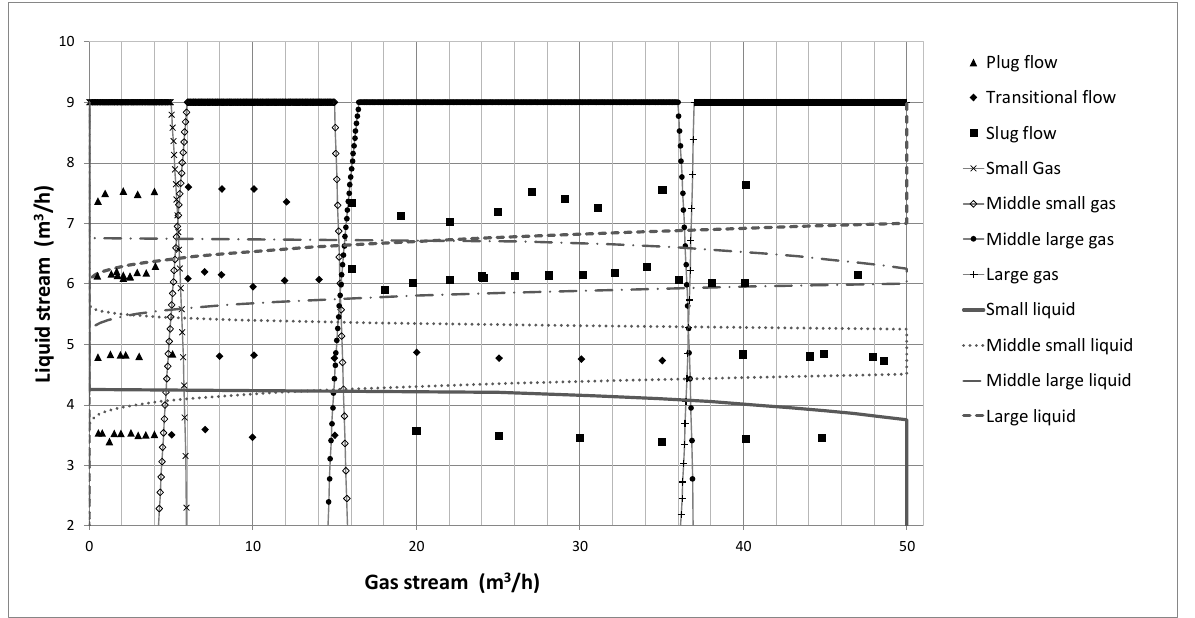
Figure 4. The series of measurement data for flows split as in Figure 3 with the scaled membership functions (9)–(12) and (19)–(22) for the parameter a equals 5. functions (9)–(12) and (19)–(22) for the parameter a equals